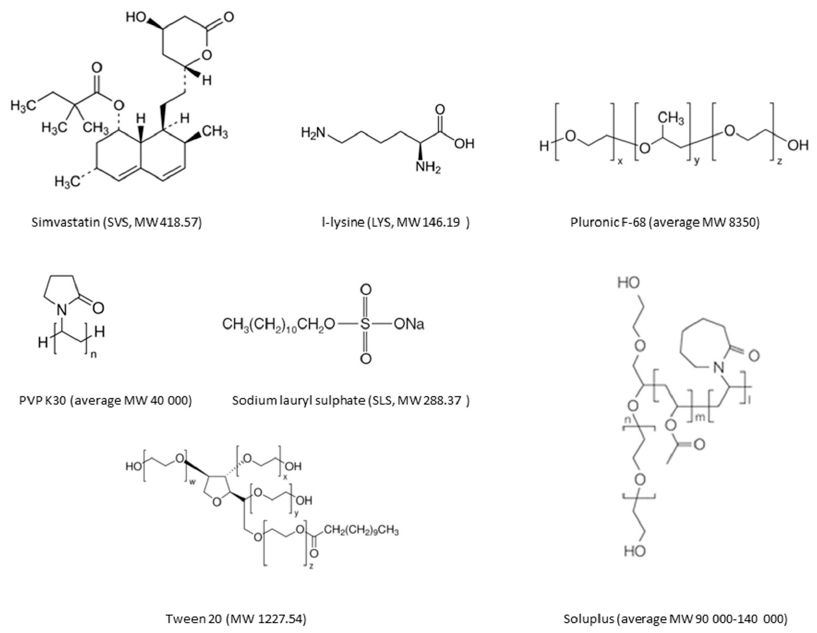
Figure 1. Molecular structures of the studied materials.